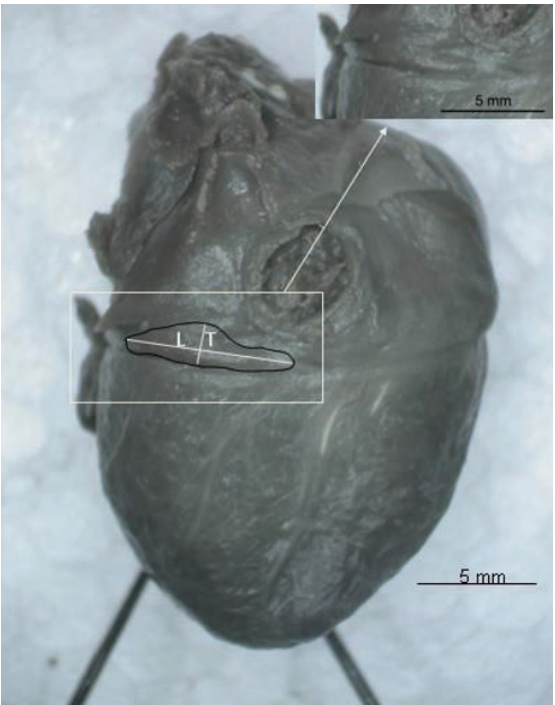
Figure 1. Diaphragmatic surface of the prenatal human heart from 19 weeks old fetus. Measured parameters: the length